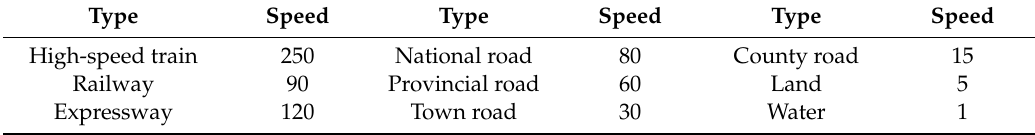
Table 1. The speed of di ff erent means of transports and land-cover (km / h). Type Speed Type Speed Type Speed High-speed train 250 National road 80 County road 15 Railway 90 Provincial road 60 Land 5 Expressway 120 Town road 30 Water